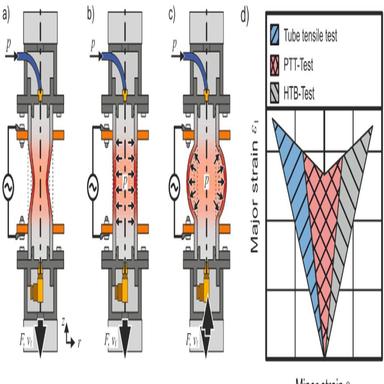
Applied experimental set-ups: a) Pressurized-tube-tensile-test (without additional internal pressure p), b) pressurized-tube-tensile test with internal pressure p and c) hot-tube-bulge test to achieve c) different strain paths for a forming limit curve (FLC).